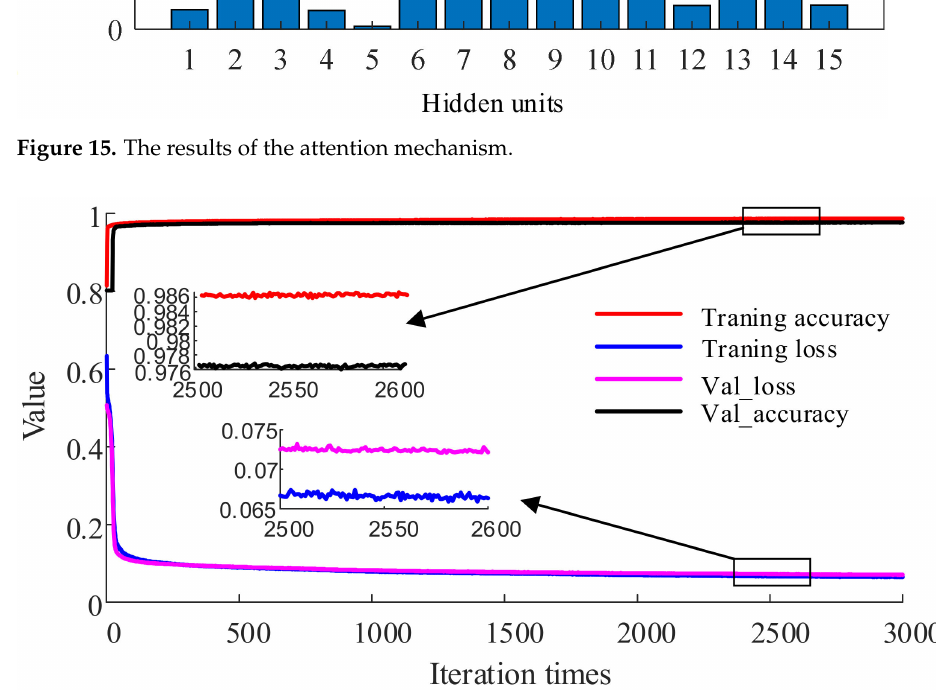
Figure 16. The accuracy and loss of the attention-LSTM